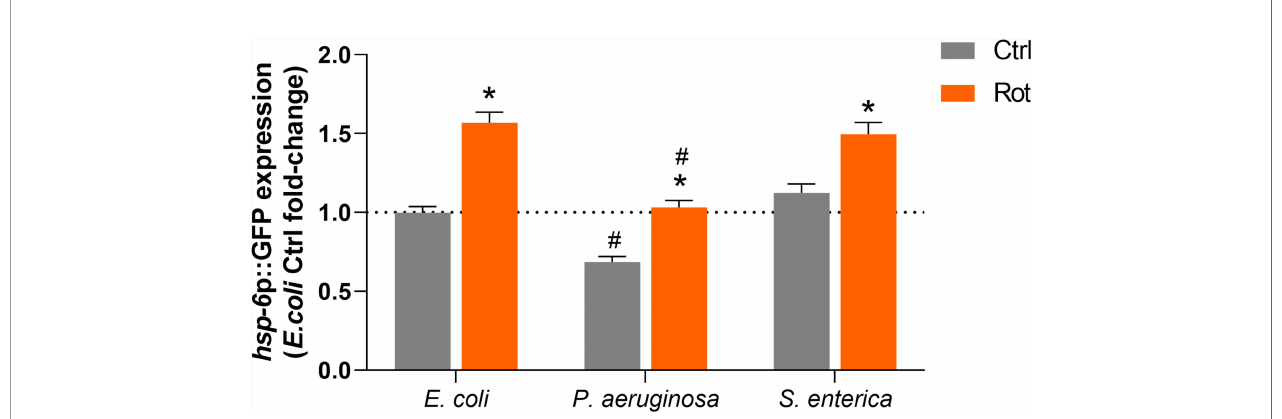
FIGURE 6 | Activation of the mitochondrial unfolded protein response by rotenone. Solvent control (Ctrl) and rotenone-exposed (Rot) SJ4100 nematodes were further exposed for 24 h to Escherichia coli (OP50), Pseudomonas aeruginosa (PA14) or Salmonella enterica (SL1344) and the GFP intensity was measured. The presented hsp-6 p::GFP fold-change results are relative to the E. coli OP50 solvent control. A two-way ANOVA with Bonferroni multiple comparison test was performed. Bars represent mean ± SEM. * represent signi fi cant difference (p < 0.05) between the rotenone and solvent control exposure groups within each bacterial feeding group. # represent signi fi cant difference (p < 0.05) comparing pathogenic bacterial exposures to E. coli within the solvent control or rotenone exposure groups. No signi fi cant interaction effect between the two independent variables – ” toxicant exposure ” and “ bacterial food source ” – was detected ( p = 0.09). However, each independent variable had a signi fi cant effect on hsp-6 p::GFP expression ( p < 0.0001 for both independent